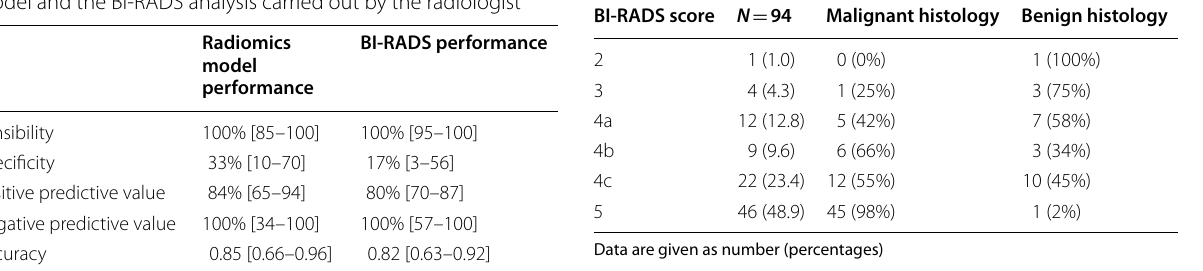
AUC Area under curve; DCE Dynamic contrast enhancement; PE Peak enhancement; SER Signal enhancement ratio; WO Washout